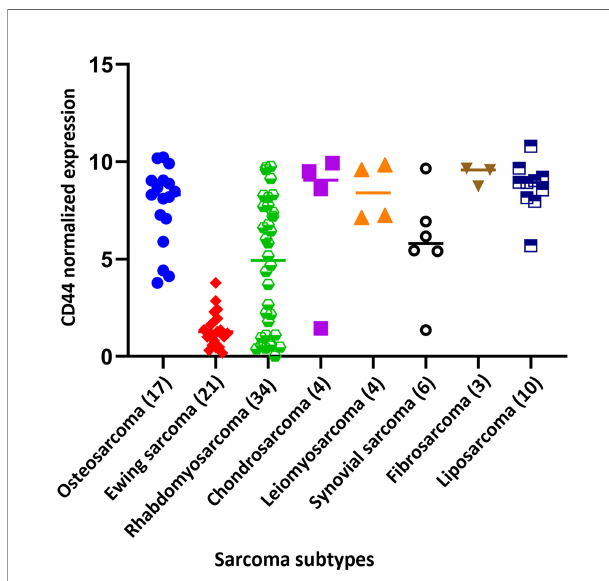
FIGURE 4 | CD44 normalized expression of the different cell line sarcoma subtypes. Data extracted from DEPMAP Portal (https://depmap.org/portal/). The number of cell lines in each sarcoma subtype is indicated in